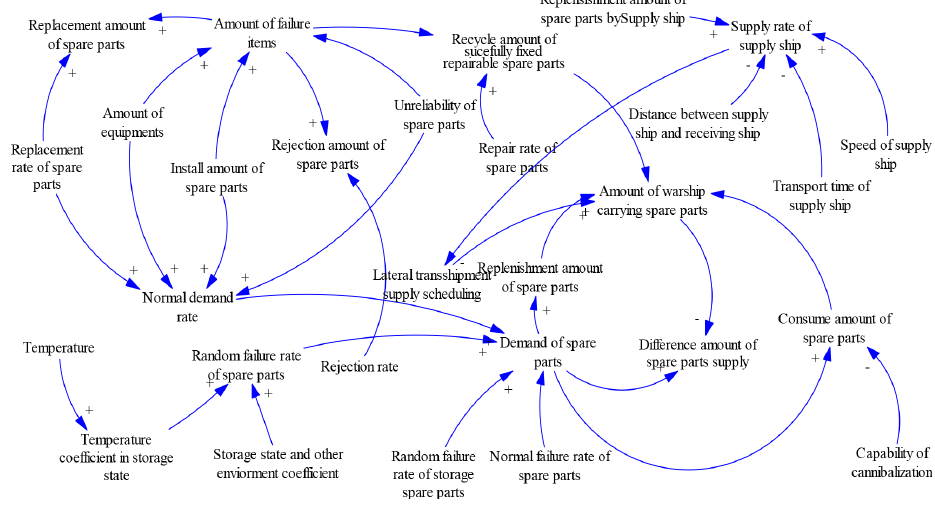
Figure 3. Causal relationship of warship spare parts support system